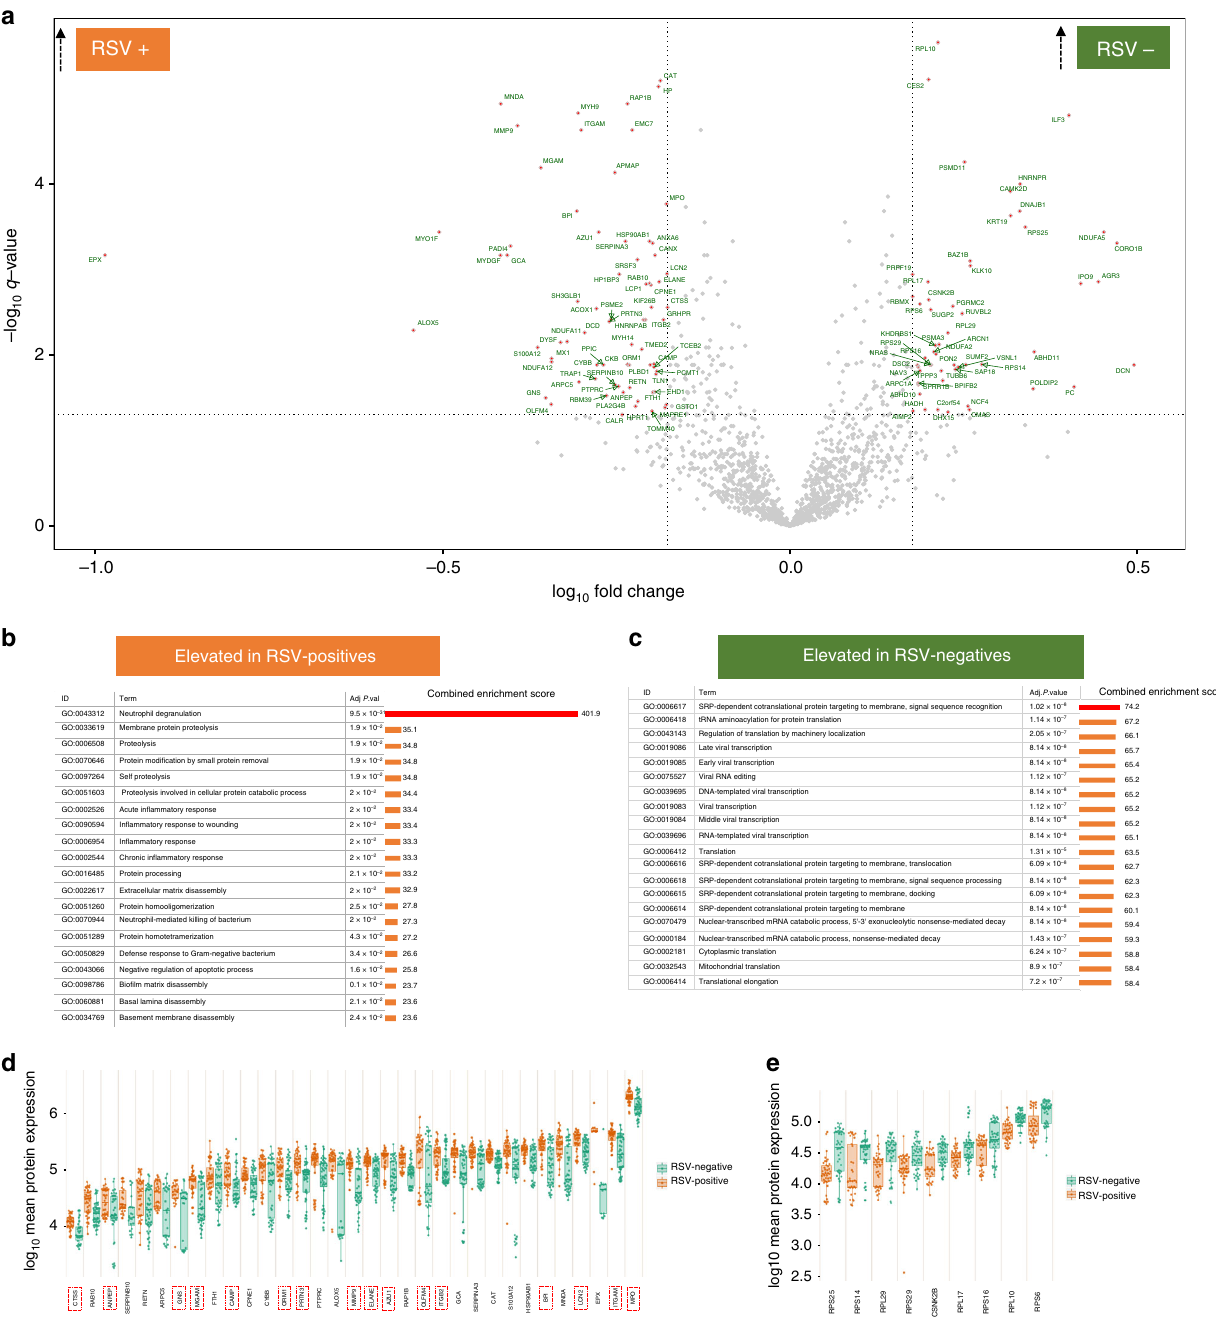
Fig. 2 Analysis of the airway proteome by tandem mass spectrometry. Analysis of airway proteomes was undertaken using mass spectrometry in a population of 40 children with RSV infection and 44 RSV-negative children. a Differences in the mean expression levels of local airway proteins between the RSV-positive and RSV-negative children was analysed using two-sided Student's t -tests and presented in a volcano plot. The y -axis represents − log 10 fdr-adjusted P values ( q values) computed using two-sided Student's t -tests and the x -axis represents − log 10 fold change in protein expression. Red circles represent differentially expressed proteins (de fi ned by q values: ≤ 0.05 and ≥ 1.5-fold change in expression between groups). Red circles in the top left and top right quadrants represent proteins that were signi fi cantly elevated in RSV-positive and RSV-negative children, respectively. b , c Gene ontology (GO)- based biological pathways analysis was used to identify biological processes that were signi fi cantly overrepresented in RSV-positive and RSV-negative children. Those that were signi fi cantly overrepresented in RSV-positive children are shown in b while those that were overrepresented in RSV-negative children are shown in c . Adjusted P -values in b and c were calculated on the enrichR platform and are based on the Fishers extract test. The most signi fi cantly enriched pathway in RSV-positive children was neutrophil degranulation and in RSV-negative children was SRP-dependent co-translational protein targeting to membrane, signal sequence recognition. d , e The speci fi c proteins that were signi fi cantly differentially expressed within those pathways are shown in d and e , respectively. The proteins highlighted with the red boxes in d are neutrophil granule proteins. The elements of the box and whisker plots are de fi ned in Fig. 1. Source data are provided as a Source Data fi